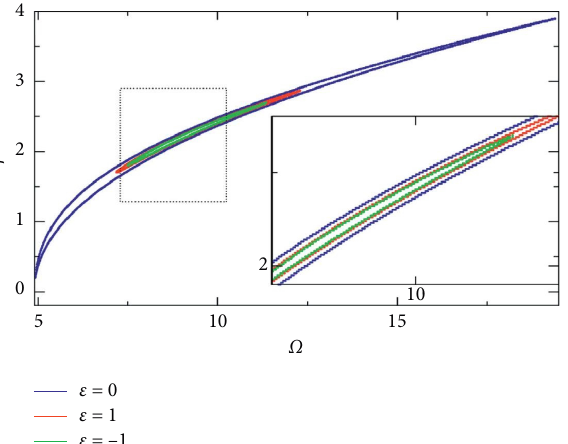
Figure 2: Effect of the passive control force direction on the frequency response curve with the parameters: ω